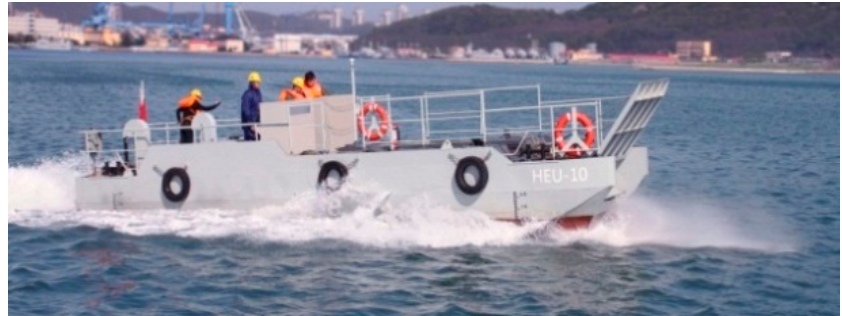
Figure 3. Twelve meter medium-sized boat on the sea.